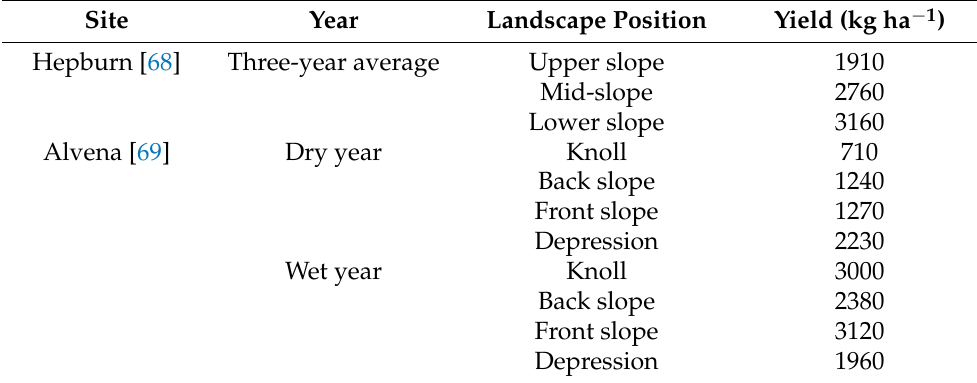
Table 5. Examples of wheat grain yield variability within landscapes in